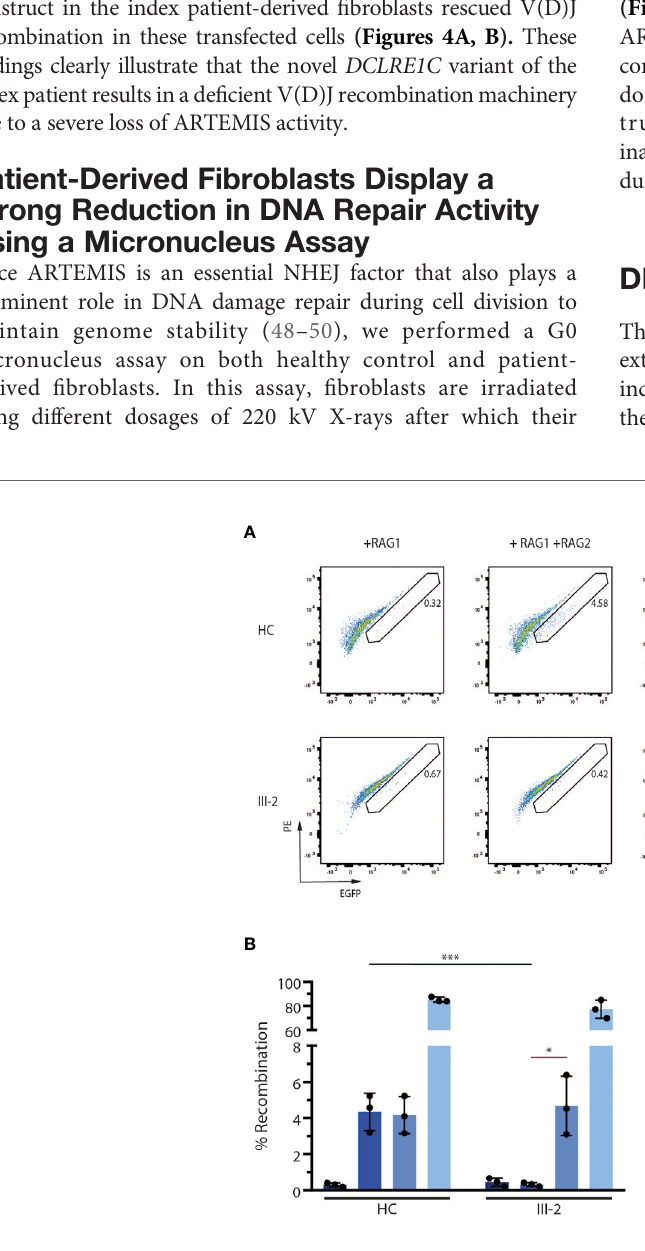
FIGURE 4 | In vitro V(D)J recombination assay shows the inability of the truncated ARTEMIS protein to contribute to V(D)J recombination. (A) Flow cytometry analysis of the EGFP expression of transfected healthy control and patient fi broblasts with the corresponding constructs as indicated above the pseudocolor plots. EGFP expression is a direct read-out of V(D)J recombination of the substrate. Numbers indicate the EGFP + percentage of the corresponding gated population. As a positive control, recombined substrates are provided ( ‘ Flipped control ’ ). Plots shown are representative for all replicates (n=3). HC, Healthy Control. (B) Graph showing the EGFP + percentage of transfected control and SCID fi broblasts with the corresponding constructs. Bars indicate the mean of the 3 independent experiments that are shown by the individual data points and error bars indicating the standard deviation (n=3). ***indicates p < 0.001 and *indicates p < 0.05 resulting from a two-tailed paired t-test. HC, Healthy